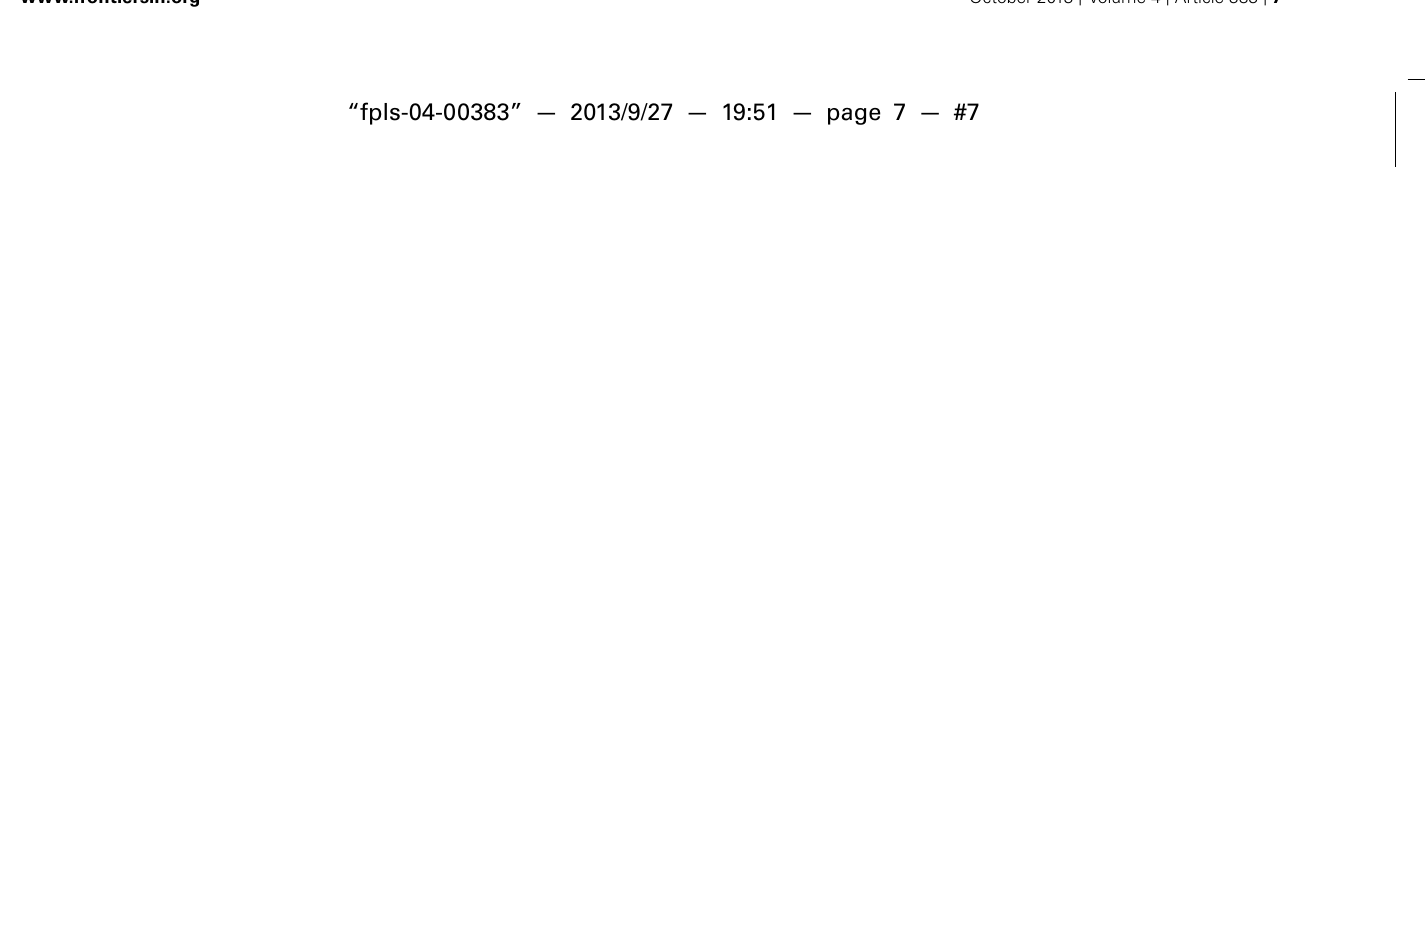
reporter constructs shown in (A) when each effector was cotransfected into Arabidopsis leaf protoplasts. LUC activity when the negative control was cotransfected was set to 1 in (B–D) . (D) Relative LUC activity of the reporter constructs indicated on the X axis when 35S:OsSWN1 or 35S:VAMP722 was cotransfected into Arabidopsis leaf protoplast. Error bars indicate SD. “*” and “**” indicate values significantly different from the negative control by Welch’s t -test with P < 0.05 and 0.01,